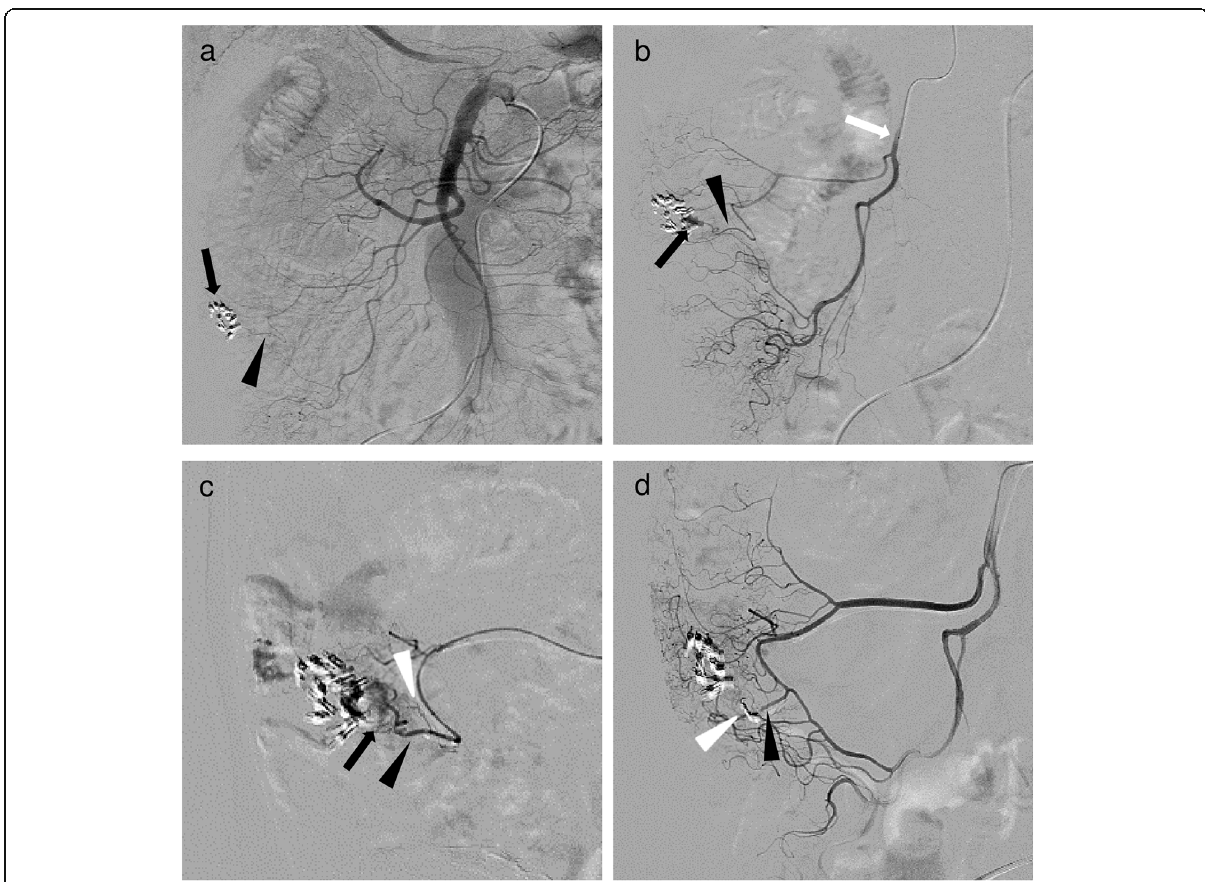
Fig. 2 A 58-year-old man with ascending colonic hemorrhage due to colonic diverticulosis. Ultraselective TAE was performed after hemostatic clipping via colonoscopy was unsuccessful. a Superior mesenteric angiography image showed the vasa recta (black arrowhead) with near clipping (black arrow); however, contrast extravasation could not be identified. b Angiography through the ileocolic artery (white arrow) with a 1.7-F microcatheter (Veloute; Asahi Intecc) showed a small and considerably bent vasa recta (black arrowhead) and contrast extravasation (black arrow). After identifying the bleeding site, a 1.7-F microcatheter was inserted into the bleeding vasa recta (not shown). c Selective angiography through the vasa recta showed a short branch (white arrowhead) and contrast extravasation (black arrow) from the long branch (black arrowhead). d Two microcoils (Target Nano Coils; Stryker) of 1 mm in diameter and 2 cm long (white arrowhead) placed at the site of contrast extravasation and the bleeding branch. After ultraselective TAE, angiography through the ileocolic artery showed disappearance of